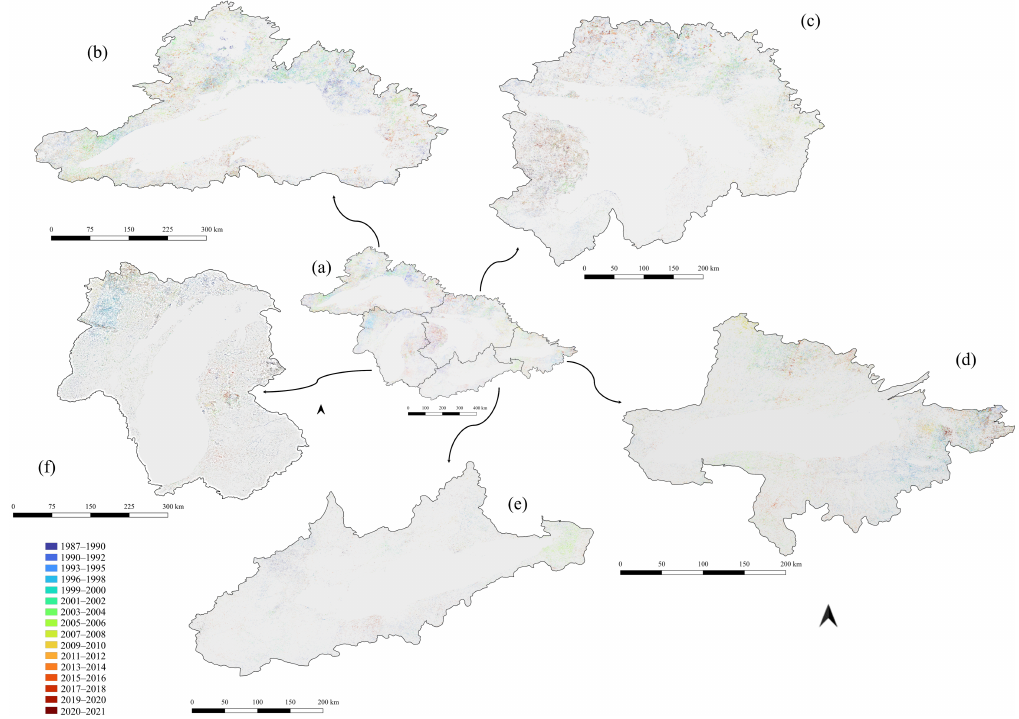
Figure 17. Wetland loss maps of the ( a ) Great Lakes basin and ( b – f ) its subbasins (i.e., Lake Superior, Lake Huron, Lake Ontario, Lake Erie, and Lake Michigan, respectively) at different time